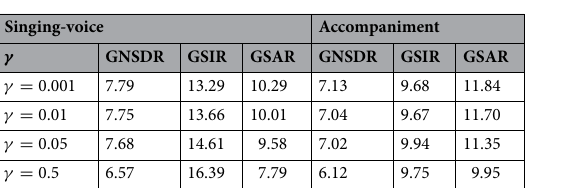
Figure 5. The PESQ and MOS-LQO values on the test set of the MIR-1K dataset under the RNN and our CRNN-A.